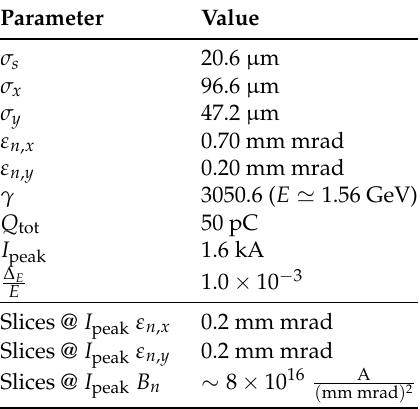
Table 4. Beam parameters at 2nd injection in L1. The slice parameters refer to a cut that keeps 31 pC of the 50 pC total bunch